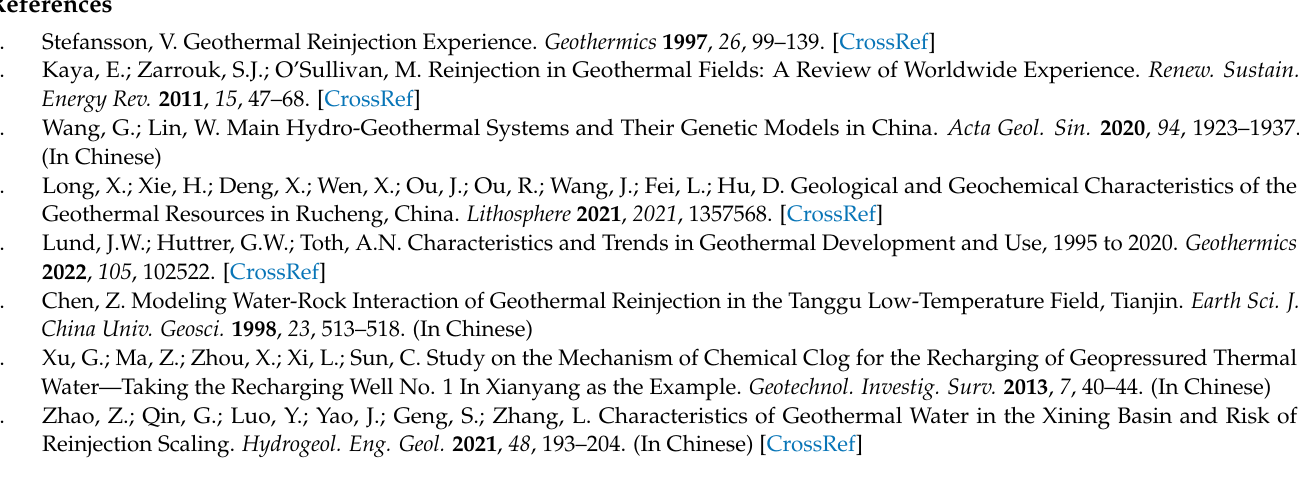
Table S2: Scheme for simulating dissolution and precipitation for the 65 ◦ C—0.5 mL/min group; Table S3: Simulated precipitation and dissolution of minerals after